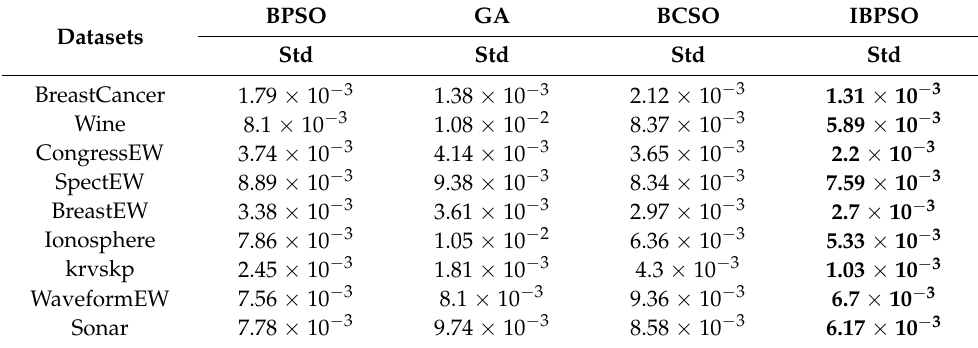
Table 4. Comparison between IBPSO based on standard deviation.